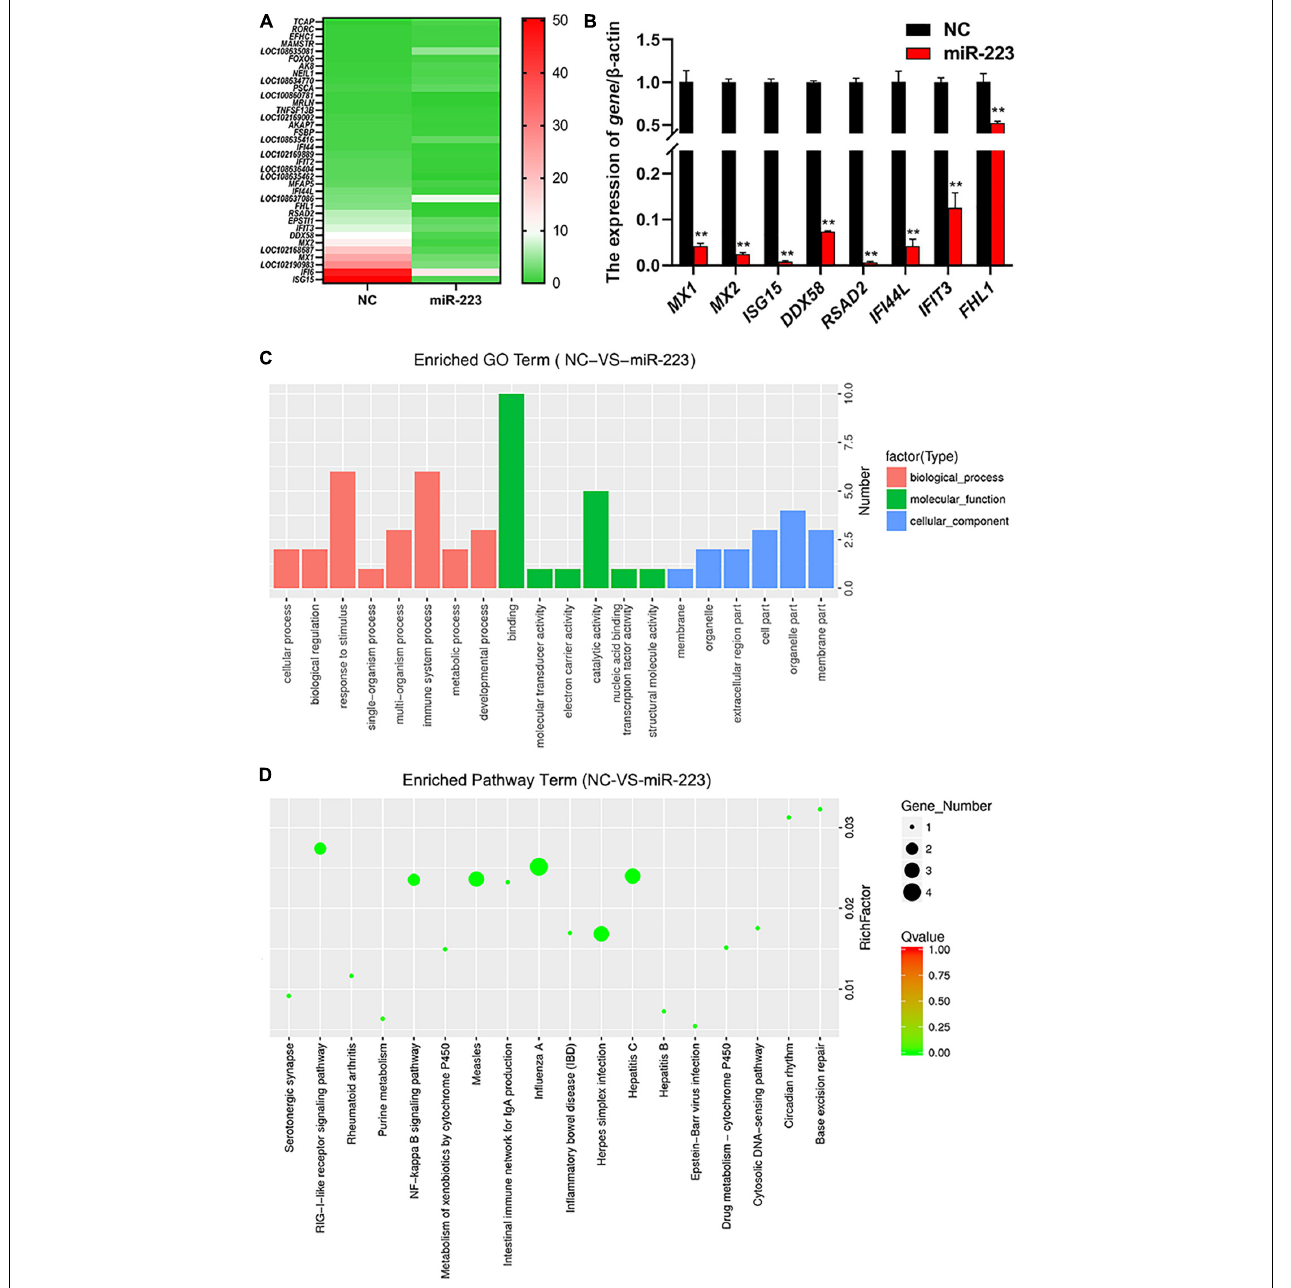
FIGURE 2 | The analysis of differentially expressed genes induced by miR-223. (A) The downstream genes regulated by miR-223. MiR-223 and NC were transfected into gMECs, respectively, and gMECs were harvested after 48 h for RNA-seq to screen differentially expressed genes of miR-223, which were shown in the heatmap. (B) The accuracy test of RNA-seq by RT-qPCR. Eight differentially expressed genes were randomly chosen to ensure the accuracy of the RNA sequencing by RT-qPCR, and the result showed that the result of RNA-seq was reliable. (C,D) GO analysis and KEGG pathway analysis of differentially expressed genes of miR-223 were conducted to predict the function of miR-223. It showed that the differentially expressed genes involved in 20 GO terms (C) , and 18 KEGG pathways (D) . ** p <